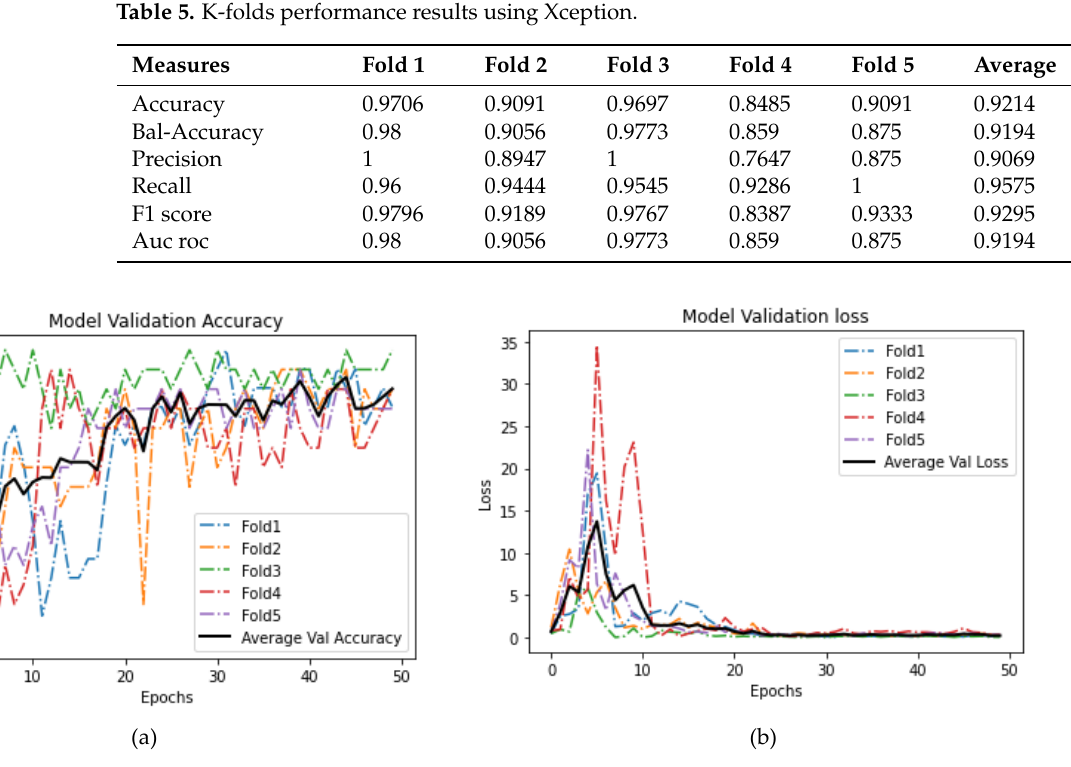
Figure 5. Validation accuracy and loss curve for ResNet50V2 . (a) Model Validation Accuracy; (b) Model Validation Loss.